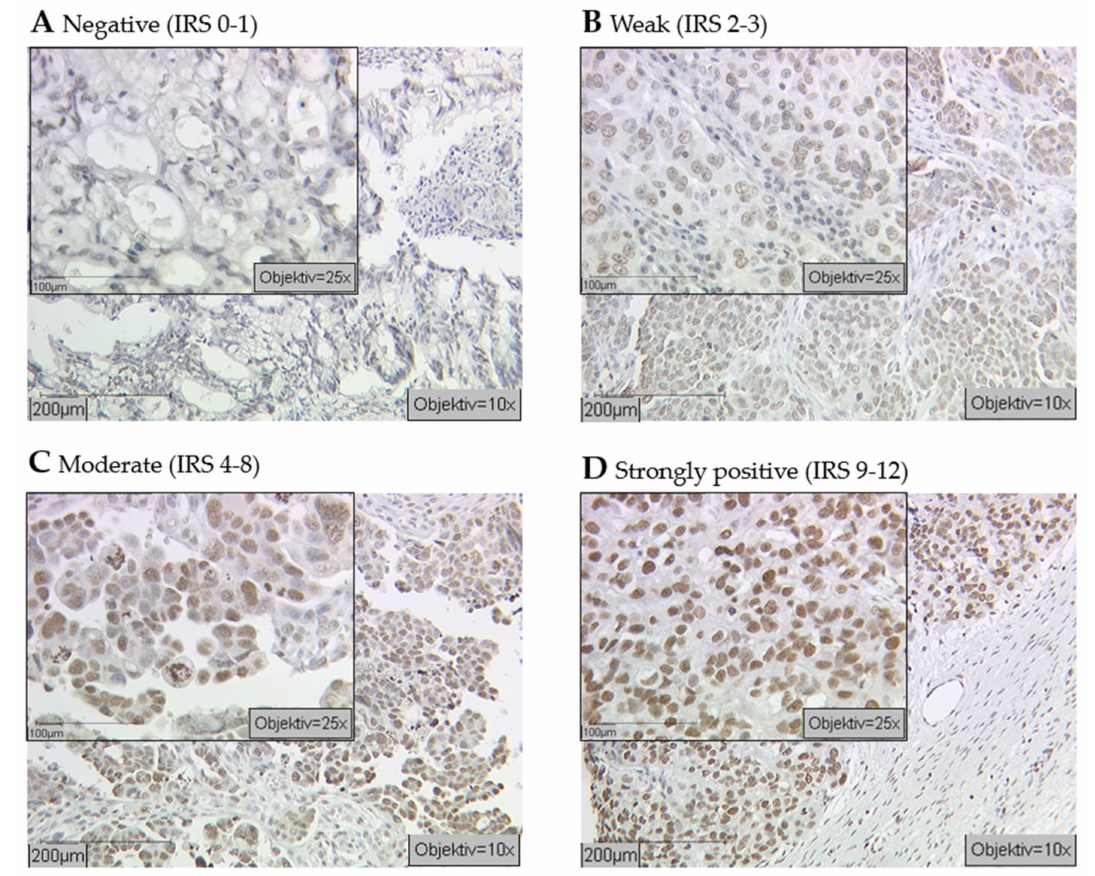
Figure 1. Cellular epigenetic heterogeneity in cancer: Immunohistochemical examination of ovarian cancer tissues with an antibody against histone Histone H3 tri methyl K4 (H3K4me3) revealed di ff erent expression levels (indicated by brown staining). Specimens were attributed to negative ( A ), weak ( B ), moderate ( C ), and strongly positive ( D ) expression levels of H3K4me3 (scale bar 200 µ m, small pictures 100 µ